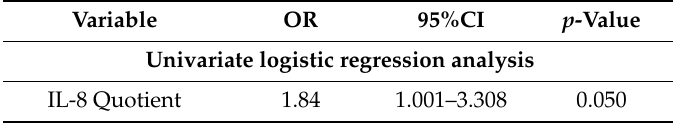
Table 4. Univariate logistic regression analysis results for UIA diagnosis. Variable OR 95%CI p -Value Univariate logistic regression analysis